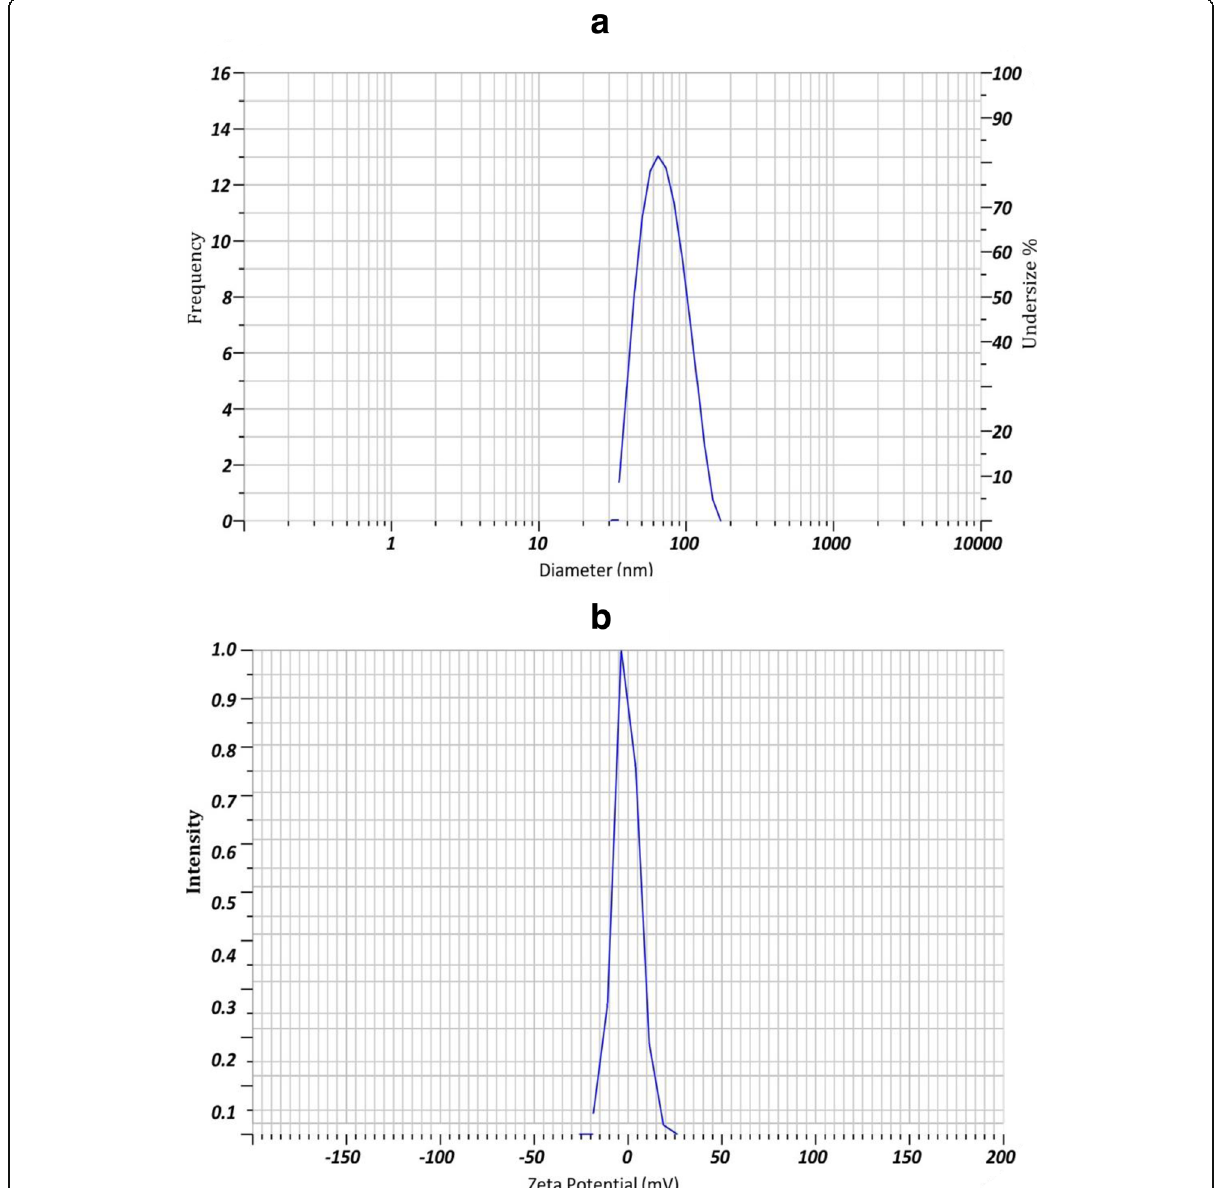
Fig. 4 a Droplet size of optimized formulation. b Zeta potential of optimized